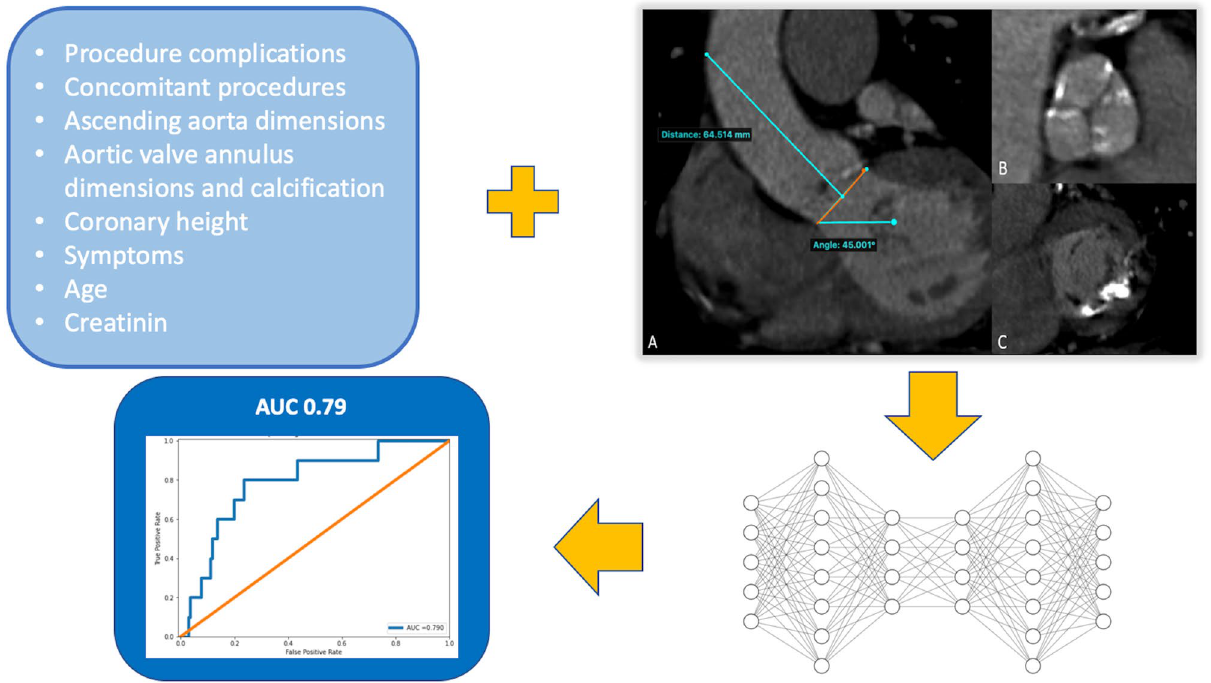
Figure 1. Graphic representation of the presented predictive model. CT imaging and other clinical data are entered in the autoencoder predictive model to yield an estimation of the risk of a cerebrovascular event (stroke or transient ischemic attack). ( A ) CT sagittal view of the ascending aorta and left ventricular outflow tract. In orange is presented the aortic annulus plane. In cyan are presented the ascending aorta length and the annulus angulation. ( B ) transverse view of aortic valve cusps with calcium in the setting of a degenerative aortic stenosis. ( C ) transverse view of a mitral valve with calcium. Ascending aorta length: distance at which the line drawn perpendicular to the aortic valve annulus plane hits the ascending aortic wall (important note: this is different from the usual measurement which corresponds to the distance between the brachio-cephalic trunc and the aortic annulus). Right coronary cusp height: perpendicular distance between the outflow of the right coronary and the aortic annulus. The autoencoder model is represented here by a simplified continuous variables and 0 for categorical variables) on model performance. The selected variables are displayed ranked by importance in Supplementary Table 2 and Fig. 2. Statistical analysis. Continuous and categorical variables are presented as medians (interquartile range) and as counts (percentage). Those were assessed with Mann–Whitney U test for continuous variables, and Chi square or Fisher exact test as appropriate for categorical variables. Collinearity was assessed prior to model building by analysis of the correlation matrix. Missing values ranged from 3.2 to 17.5% (overall 7.6%) and were treated with multiple imputations by a Monte Carlo dropout autoencoder 25 . Model performance was evaluated on the test set calculating the AUC. The overall database was randomly split into a train dataset (2/3 of total) used for model training and an independent test dataset (1/3) used for performance evaluation. The validation set represented 20% of the training set. The model was trained using python 3.7.9 and keras 2.4.3 software on MacBook Pro 2.4 GHz 8-Core Intel Core i9.